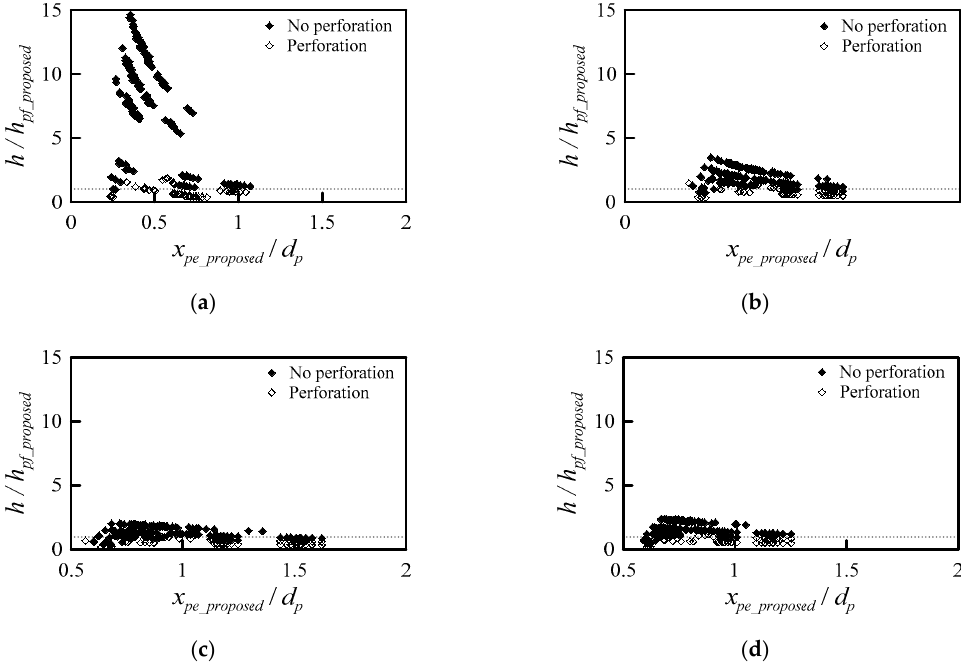
Figure 10. ( a ) Proposed formula; ( b ) modified NDRC; ( c ) Hughes formula; ( d ) ACE formula. Panel thickness ( h ) divided by predicted perforation limit thickness ( h pf ). Table 3. Accuracy of perforation limit thickness formula.